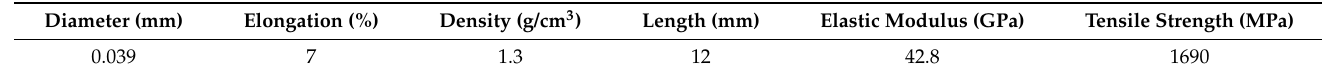
Table 2. Physical and mechanical properties of the PVA